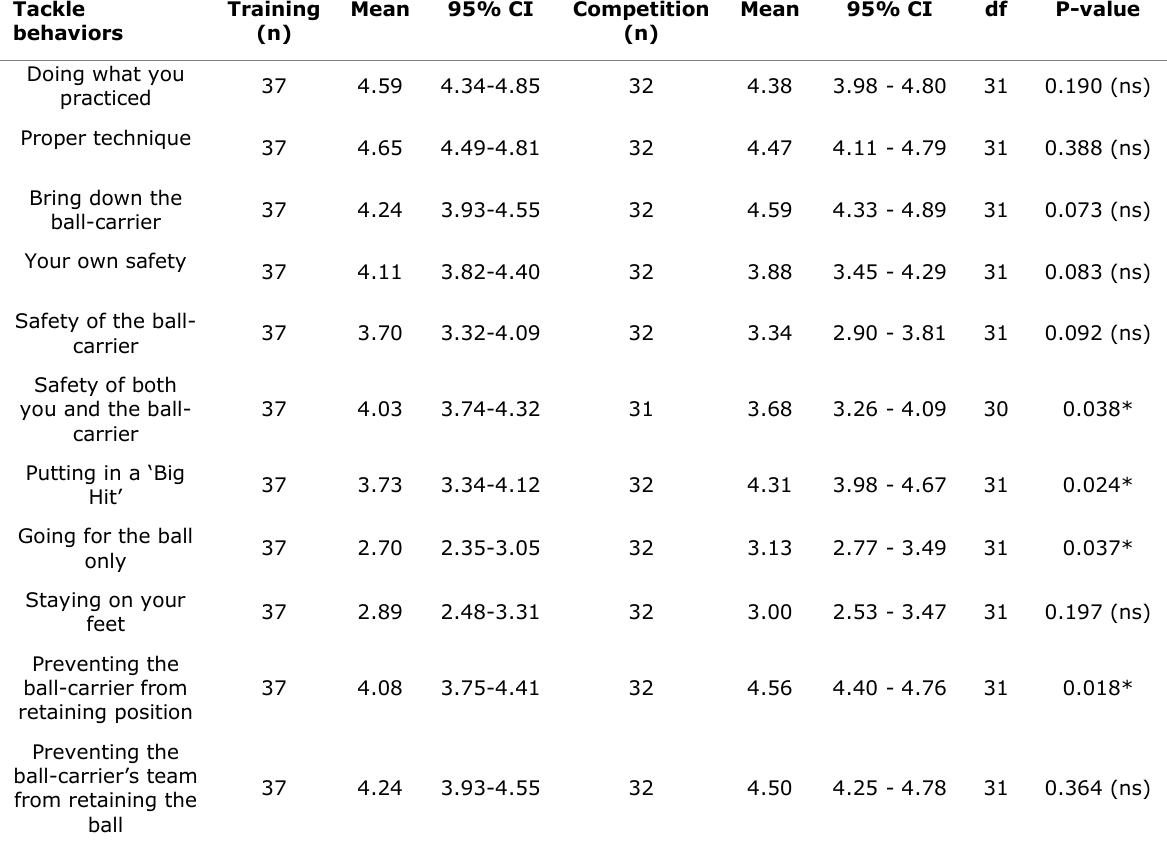
Table 3. Mean ratings of importance for tackle attitudes and